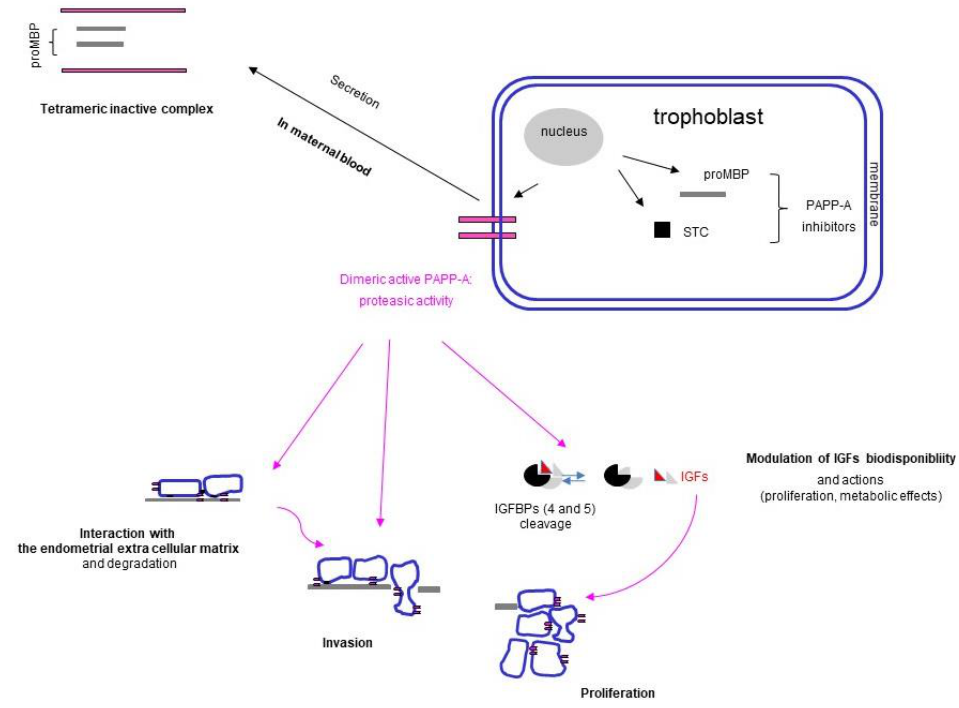
Figure 3. Structure and main functions of pregnancy-associated plasmatic protein A (PAPP-A).